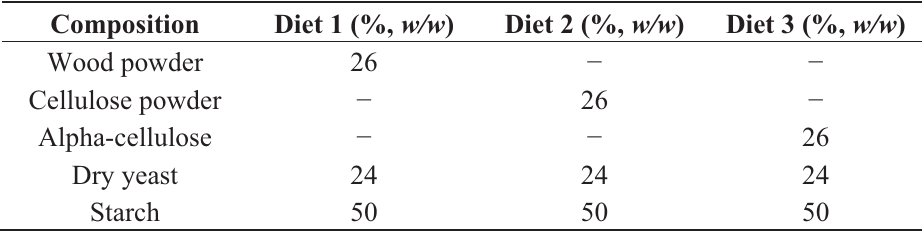
Table 1. Composition of the three artificial diets for L.